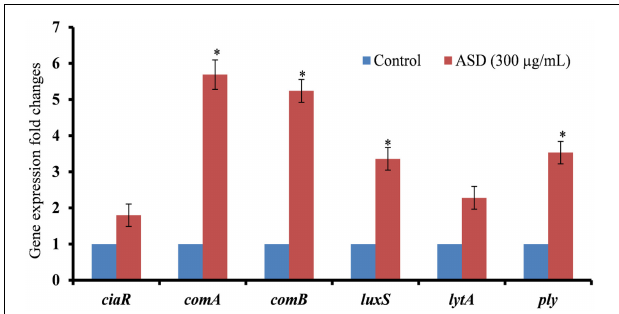
FIGURE 4 | Fold changes in the gene expression of S. pneumoniae D39 biofilm grown in metal ion-free medium supplied with 300 µ g/ml ASD for 48 h. The differential gene expression was detected by real-time RT-PCR. The error bars representing standard deviation from mean, and statistical significance were calculated by Student’s t -test and ∗ P -value less than 0.05 was considered significant.